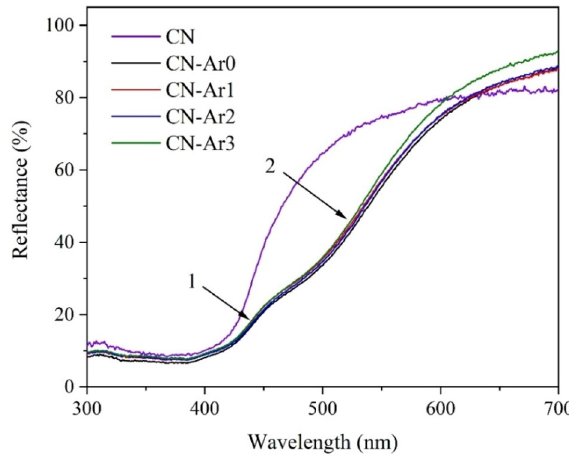
Figure 1. UV–Vis reflectance spectra of CN and CN-Ar